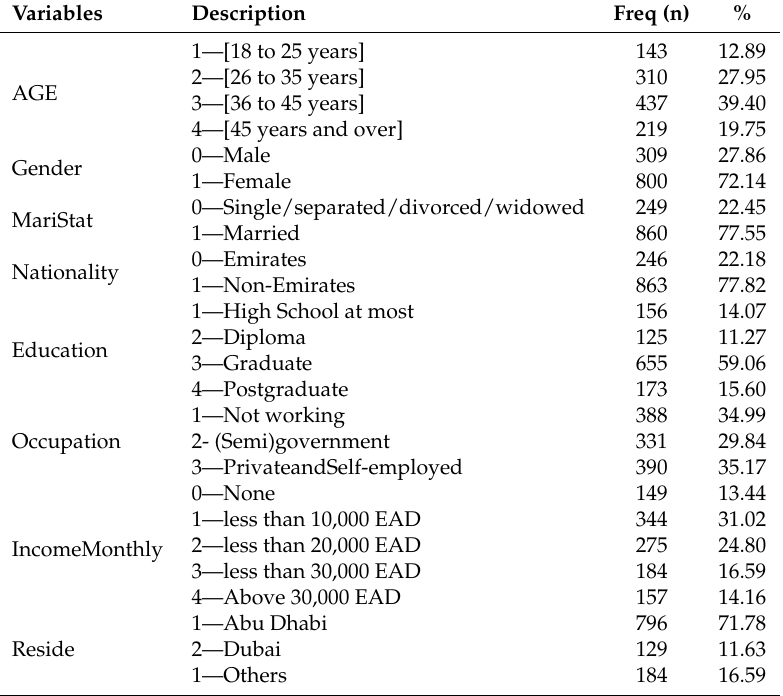
Table A2. Socio-economic and demographic characteristics of the participants (n =